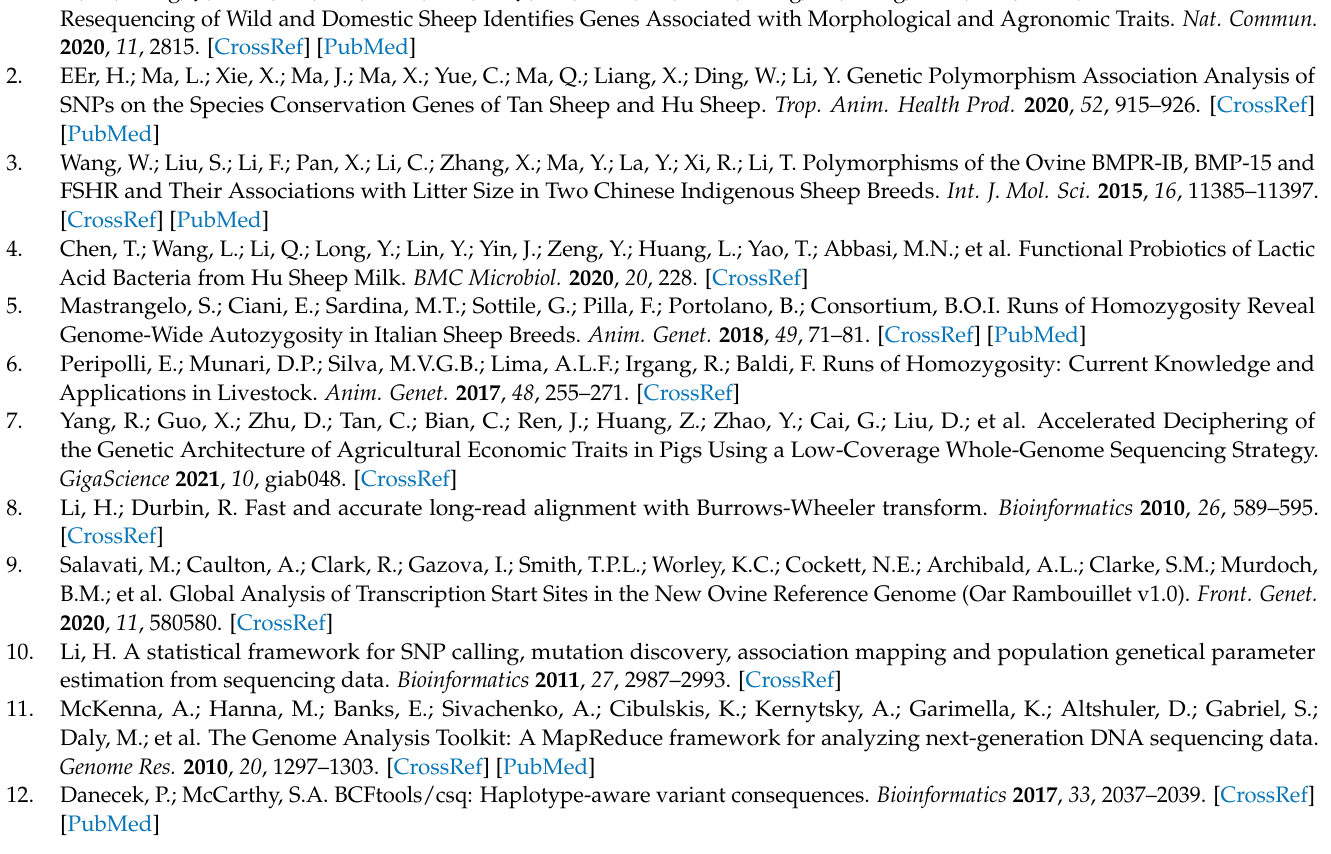
Table S4: Candidate gene enrichment based on human GWAS and TWAS